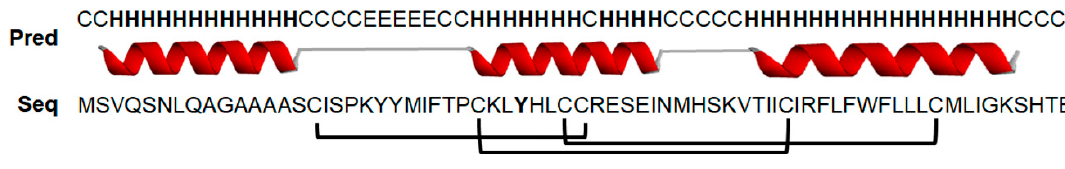
Figure 2. Prediction of the secondary structure of the N-terminal extended 70 aa. BChE fragment with p.C-11Y (rs1126680) (or p.C31Y from the start of the protein) using PSIPRED server [55,56]. H = helix, E = strand, and C = coil. The cysteine residues can form disulfide bridges leading to link and stabilization of 3 helical regions (black parentheses). Disulfide bonds formation between the cysteine residues were predicted using DISULFIND server [57].